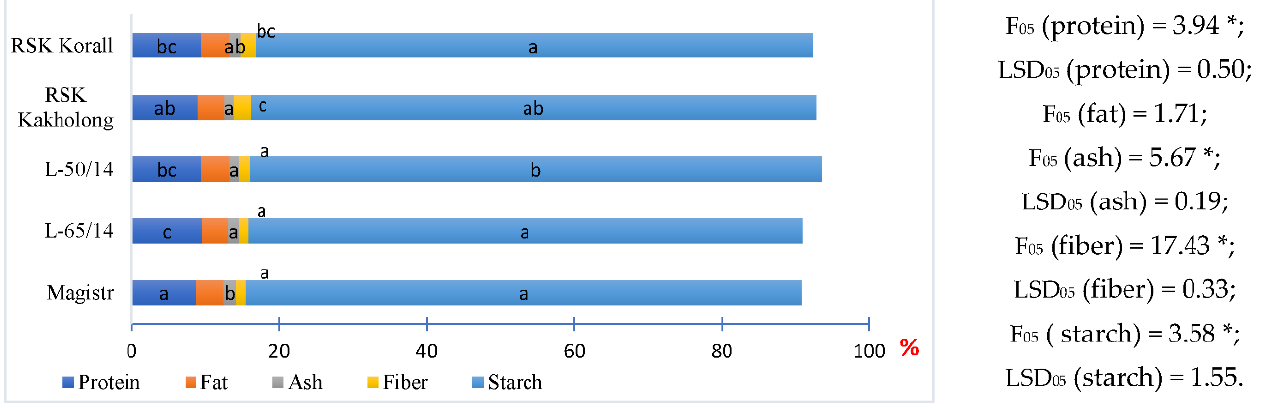
Figure 2. Biochemical composition of sorghum grain (average for 2021–2022), %. Note: * p ≤ 0.05. Different letters indicate values that differ significantly from each other in the column or the table by comparison with the Dunn’s test.